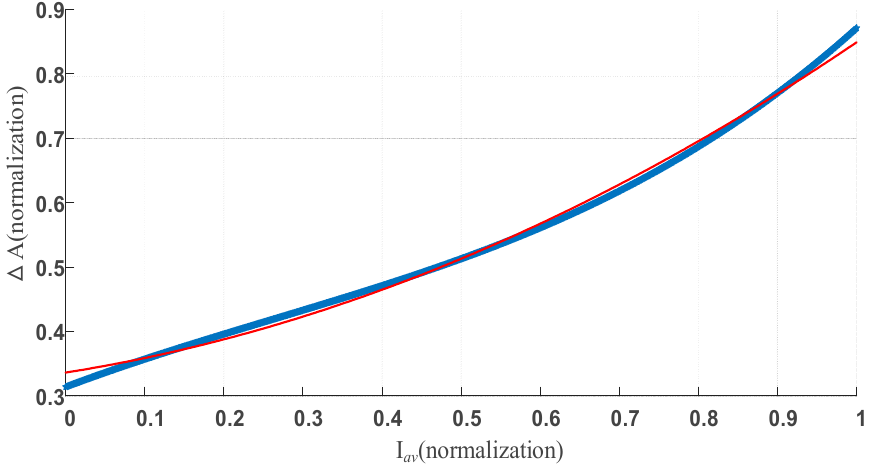
Figure 3. Correlation between the I av and Δ A .